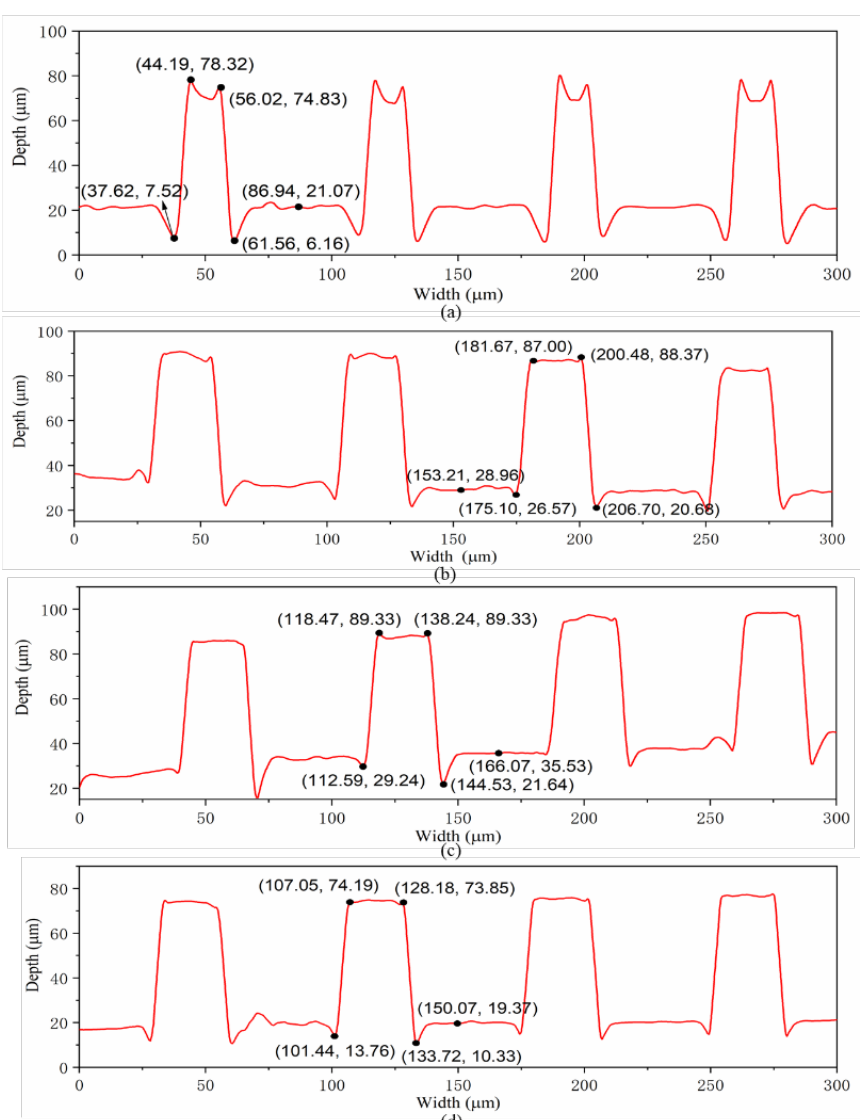
Figure 10. Profiles of microstructure after the first demolding by the laser confocal microscope: ( a ) no coating; ( b ) DT; ( c ) DDT; ( d ) PFDT.